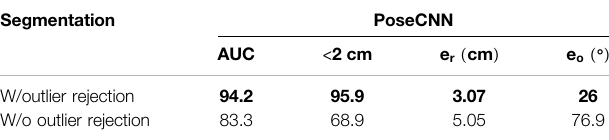
TABLE 5 | Effect of the outlier rejection procedure on the performance of MaskUKF with PoseCNN segmentation (averaged ADD-S and RMSE).A bold entry indicates a strictly better result (i.e. if different algorithms have the same best result, the associated entries are not bolded).